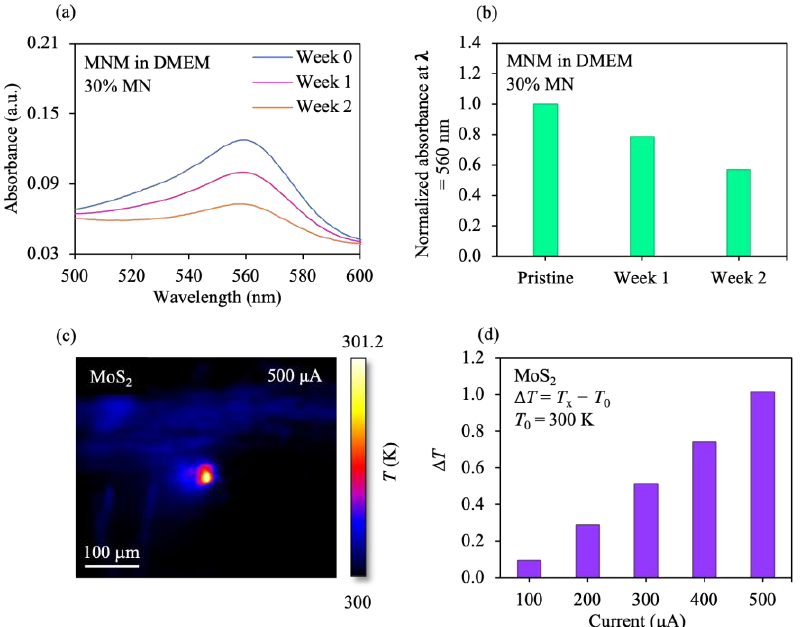
Figure 4. Stability and electrothermal effects of MNM. ( a ) UV-vis absorbance spectra of the MNM in the DMEM solution, with 30% MN for different weeks. The 2D material-based samples utilized by other research groups have demonstrated absorbance spectra with a decrease in the absorbance due to degradation [22,39]. A similar set of spectra were obtained for the samples used in this work, indicating that our results are similar. ( b ) Variation of the normalized absorbance at λ = 560 nm in ( a ) for the MNM in the DMEM, with 30% MN for different periods. ( c ) Thermographic map of the MoS 2 sample upon the application of 500 μA stimulus. ( d ) Change in temperature (Δ T ) of the sample for different stimulus currents. T x is the temperature obtained at the targeted current.